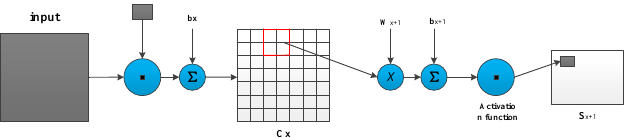
Figure 4. Typical connection between conv layer and pooling